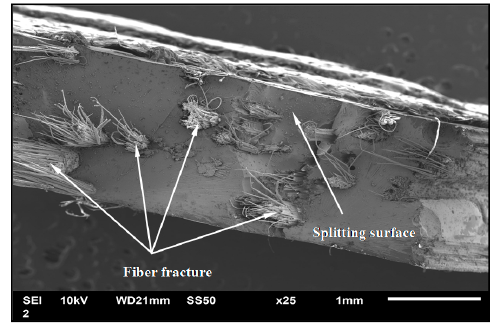
Figure 6. SEM image of fracture surface of composite.